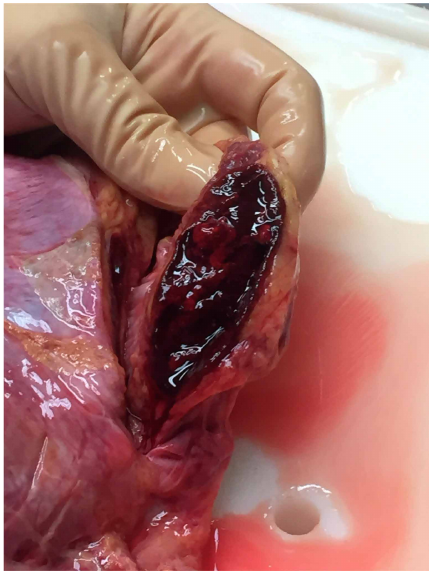
Figure 1: Adrenal hemorrhage.